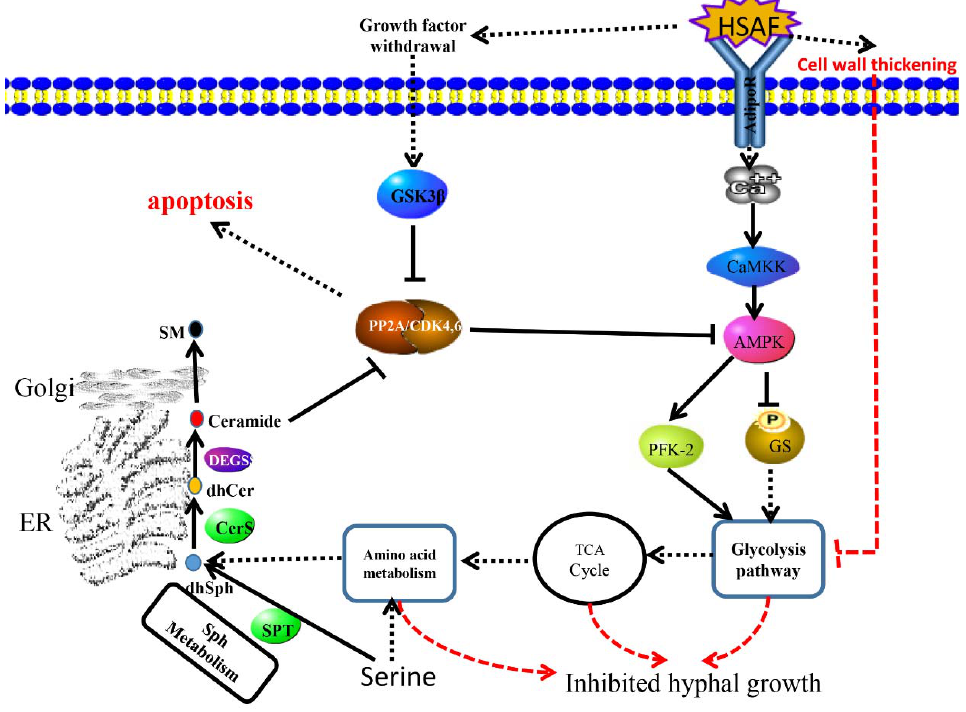
Figure 11. Hypothetical network responses to HSAF in A. alternata . The solid line represents the known reaction or step. The dotted line means uncertain steps in these pathways. Supplementary Materials: Supplementary materials can be found at www.mdpi.com/link.